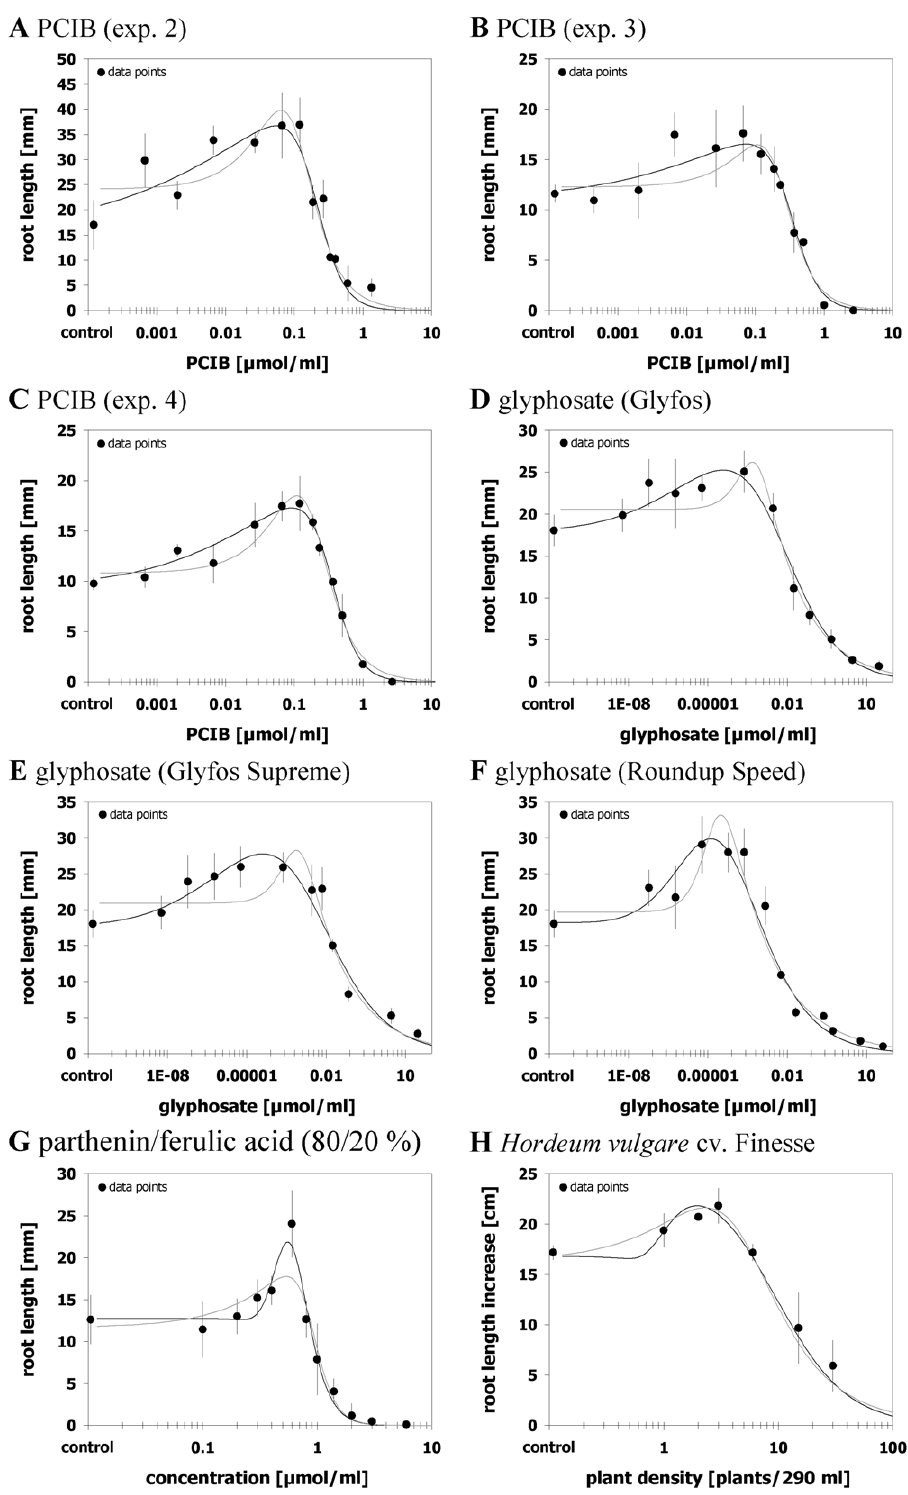
Figure 3. Cedergreen et al. model more suitable. Dose-response relationships for effects of different phytotoxins on root growth of Lactuca sativa (A–G) and for effects of root exudates of Hordeum vulgare on root growth of Sinapis alba (H) and their description by the hormetic dose- response models after Brain and Cousens [9] (grey curve) or Cedergreen et al. [2] (black curve). The Brain and Cousens model [9] detected significant hormetic responses, but provided inferior fits. Error bars represent standard deviation.